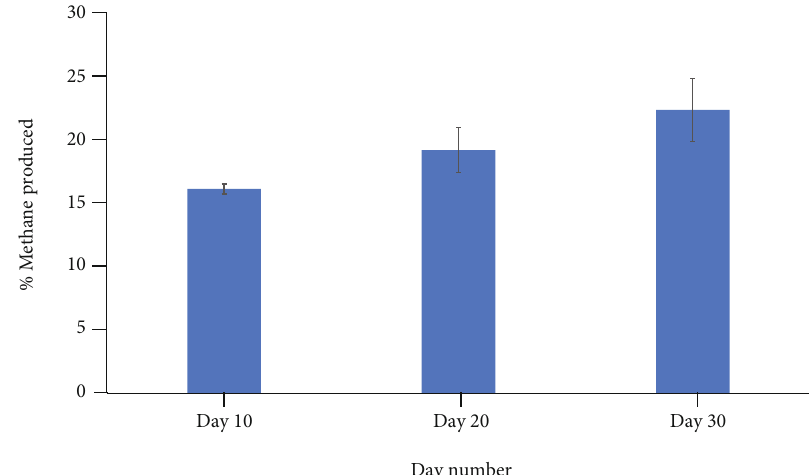
Figure 1: The percentage methane produced by Methanobrevibacter ruminantium M1 T (DSM 1093). Gas samples were taken at 10-, 20-, and 30-day time points and each data point is an average of 3 separate experiments ± SE .